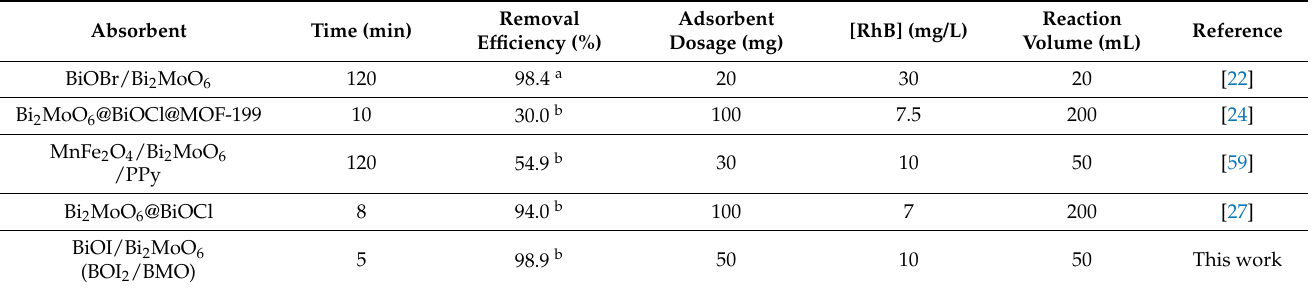
Table 1. Examples of RhB adsorption performance by Bi 2 MoO 6 -based